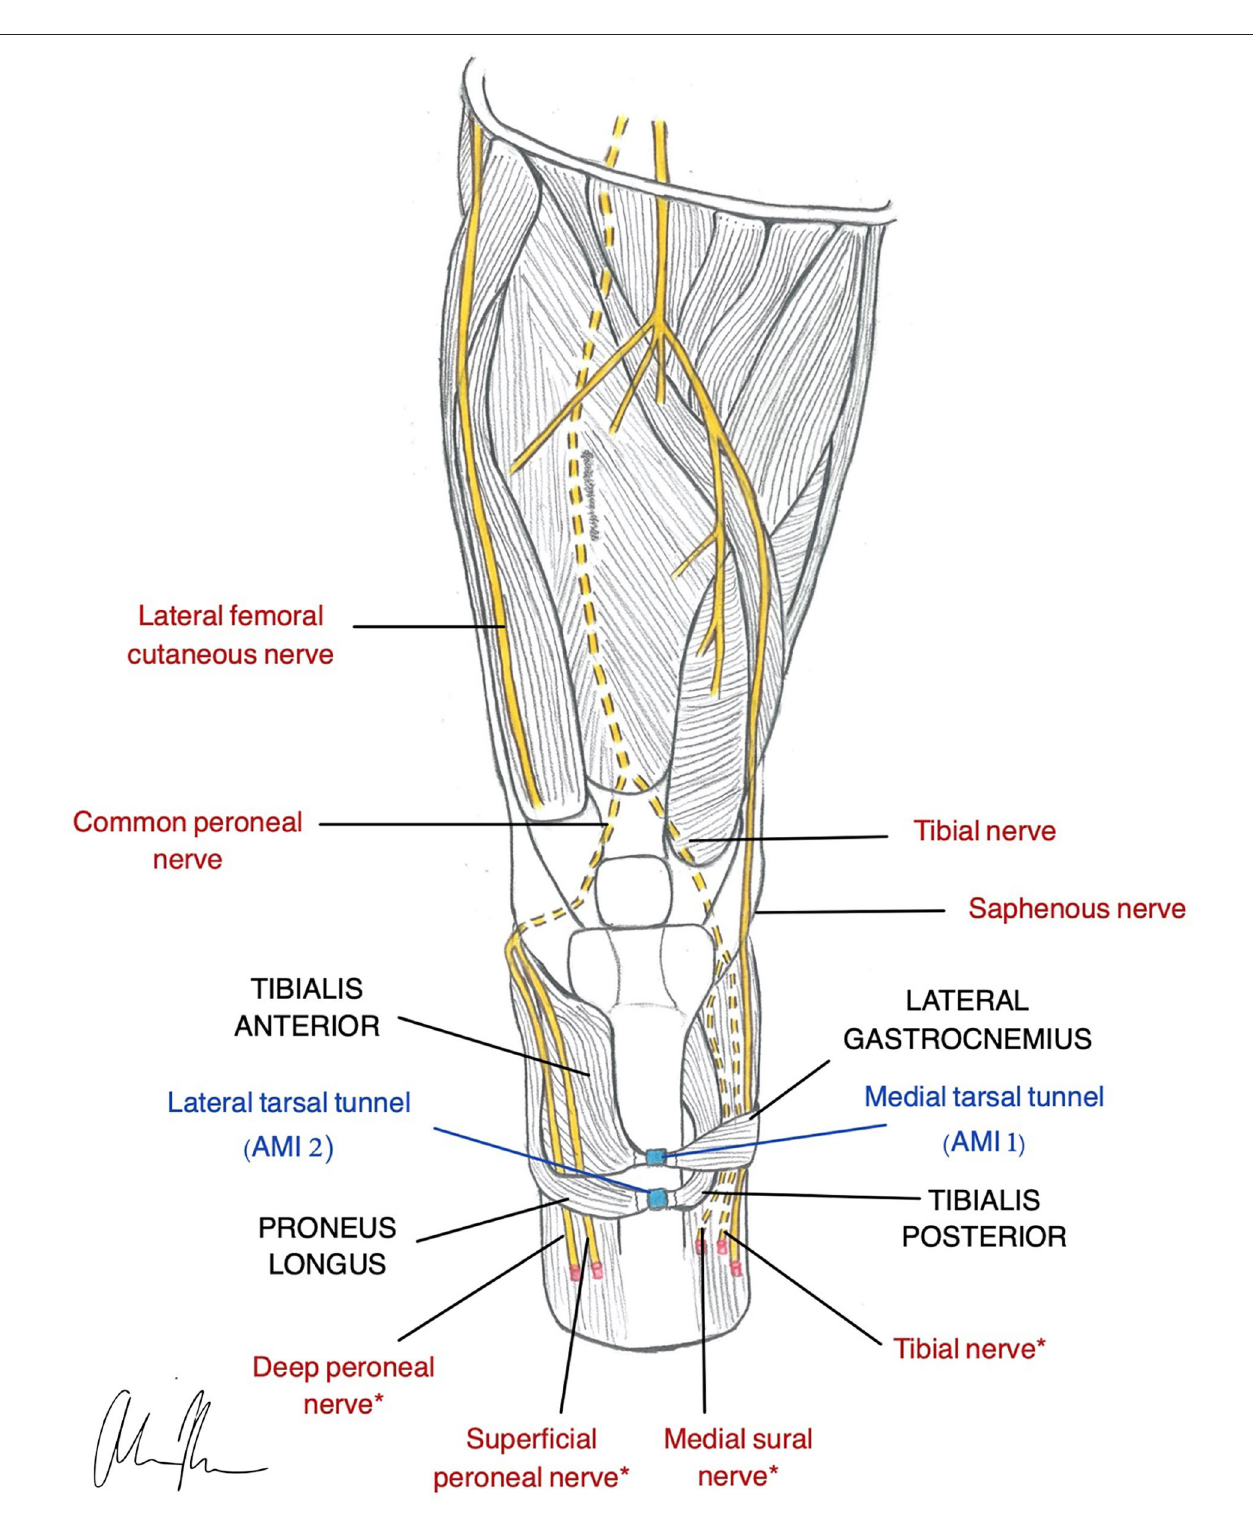
FIGURE 3 | Illustration of AMI construction in a transtibial amputee (Herr et al., 2020). Native relationship between the Lateral Gastrocnemius and Tibialis Anterior is restored using the medial tarsal tunnel (AMI 1). The Tibialis Posterior and Peroneus Longus native relationship is restored using the lateral tarsal tunnel (AMI 2). *nerves are used for RPNI for motor